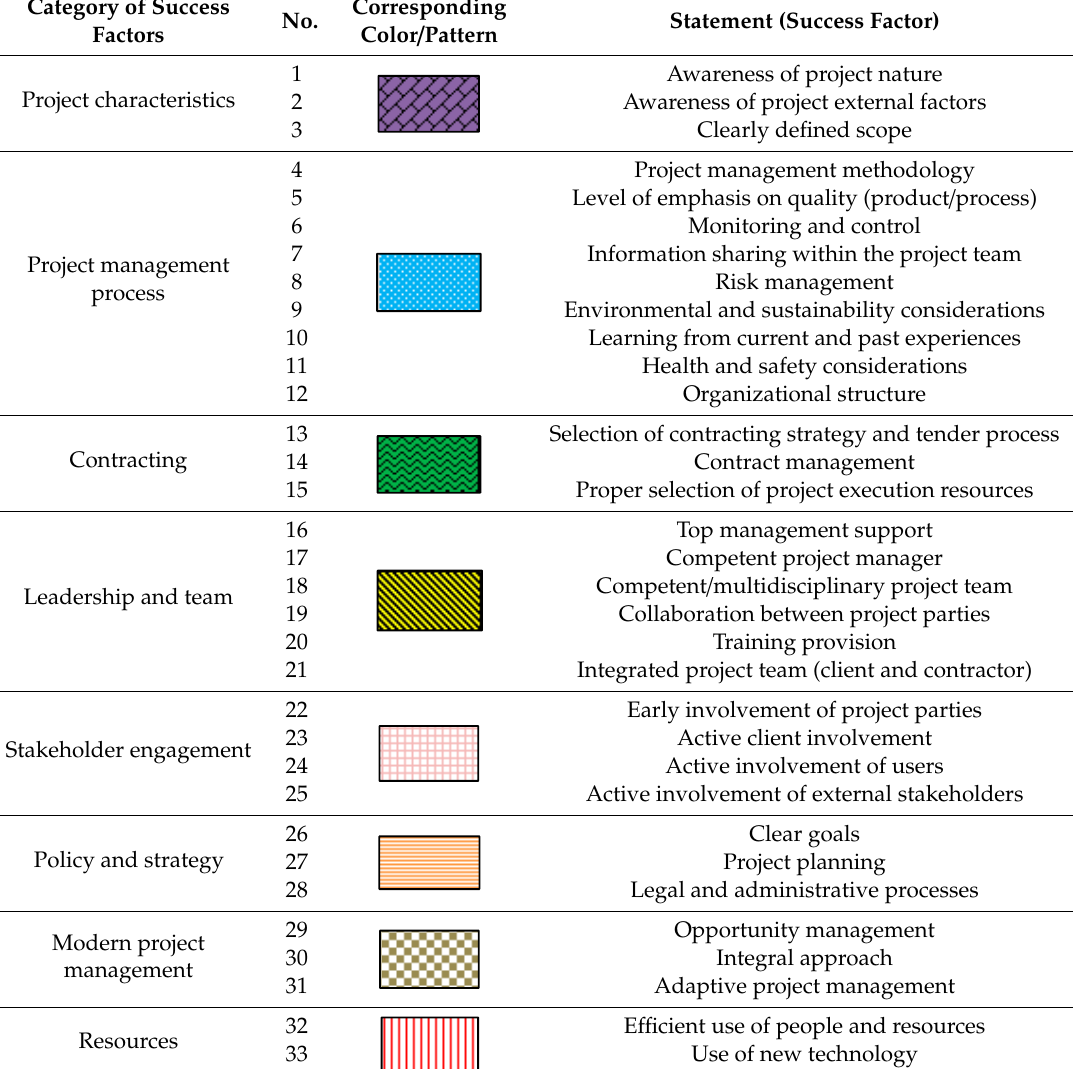
Table 1. Success factors framework that resulted from a systematic literature review and expert judgment.